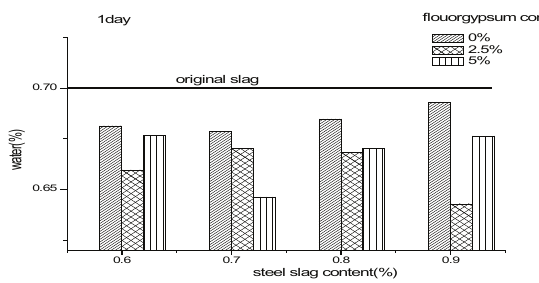
Figure 1: Moisture content change of solidified sludge (Steel slag-Activator-flouorgypsum).